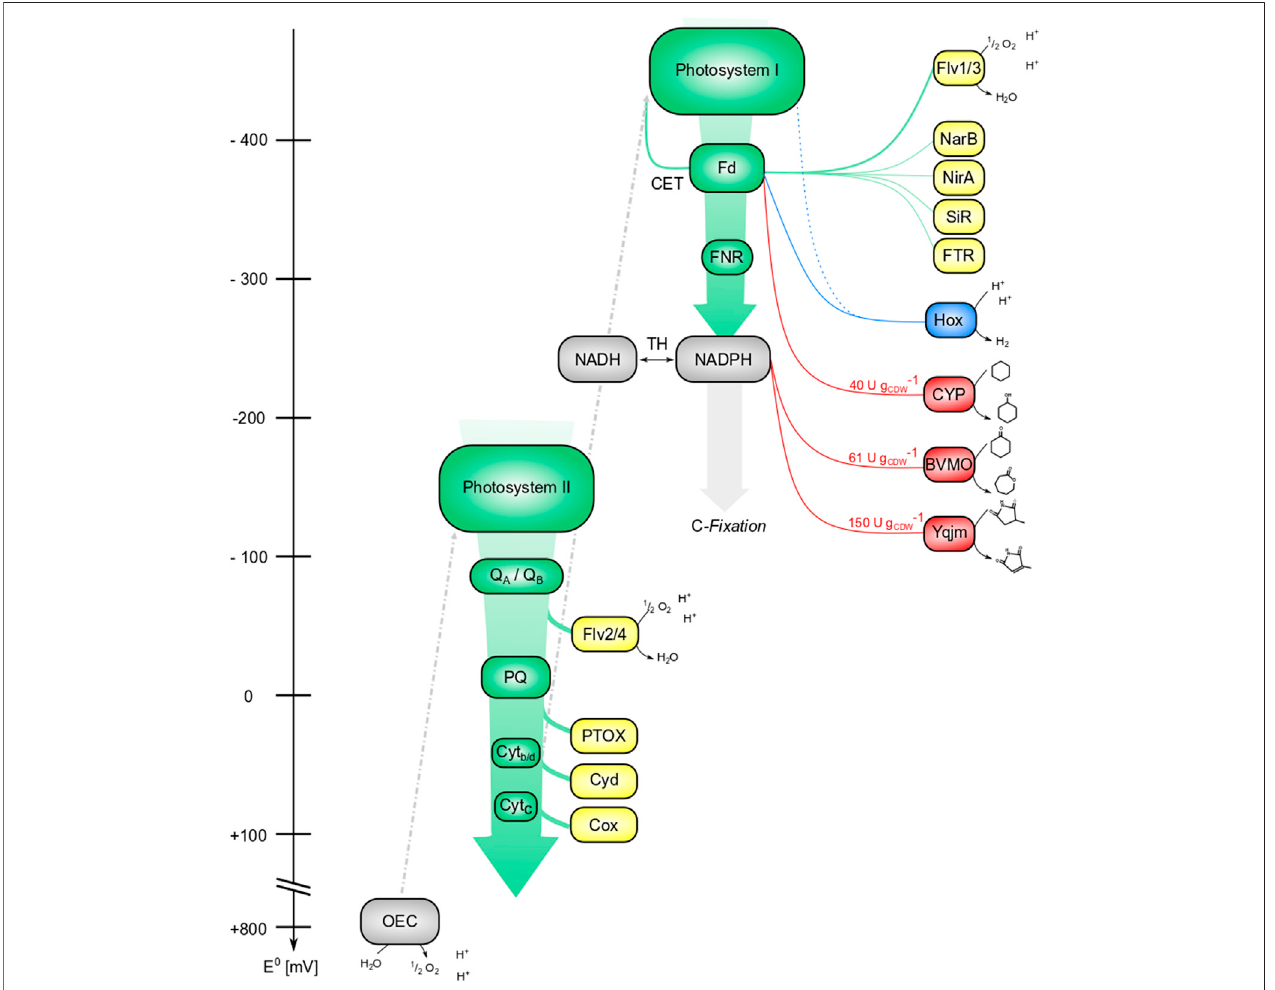
FIGURE 4 | Tapping the reductive potential of photosynthesis. Green: components of the photosynthetic electron transfer chain (PETC); yellow: internal electron sinks; blue: (native) hydrogenase (Hox); red: (recombinant) redox enzymes. Electrons derived from water splitting enter the photosynthetic electron transport chain at photosystemII,whereenergyfromlightquantapromotesthemtoahigherexcitationstate(amorenegativepotential).Thisexcitedstatecanbeusedforphotochemistry, i.e., the reduction of the primary acceptor Q A /Q B , followed by electron transport over plastoquinone (PQ) and cytochromes (Cyt b/d and Cyt c ) along a gradient of redox potentials. Photosystem I again absorbs light energy and constitutes a reducing agent strong enough to transfer electrons to Ferredoxin (Fd). The minimal redox potentialsinphotosystemsarenotdrawn toscale. Ferredoxin-NADPH-reductase (FNR)allocates abigshare ofthese electrons toNADPH,whicheither can beused for C- fi xation or can be converted to NADH by transhydrogenases (TH). Alternatively, electrons can be distributed to N- and S-assimilation (Fd-nitrate-reductase NarB, Fd- nitrite-reductase NirA, and Fd-sul fi te-reductase SiR), regulatory elements (e.g., Fd-thioredoxin-reductase FTR), or back to photosystem I, referred to as cyclic electron transfer (CET). At different points of the PETC, reductive stress can be released by transferring electrons to acceptors like the fl avodiiron proteins Flv2/4 and Flv1/3 and respiratory oxidases like the PQ-terminal oxidase PTOX, Cyt b/d - oxidase Cyd, and Cyt c -oxidase Cox. Redox potentials of electron sinks are not drawn to scale. So far, the reductivepotential ofphotosynthesis wastapped at or downstream ofPSI, byfusion constructs (dottedline), at the level ofFd (Hoxand CYP450), and at thelevel of NADPH (Baeyer-Villiger monooxygenase BVMO and ene-reductase Yqjm).